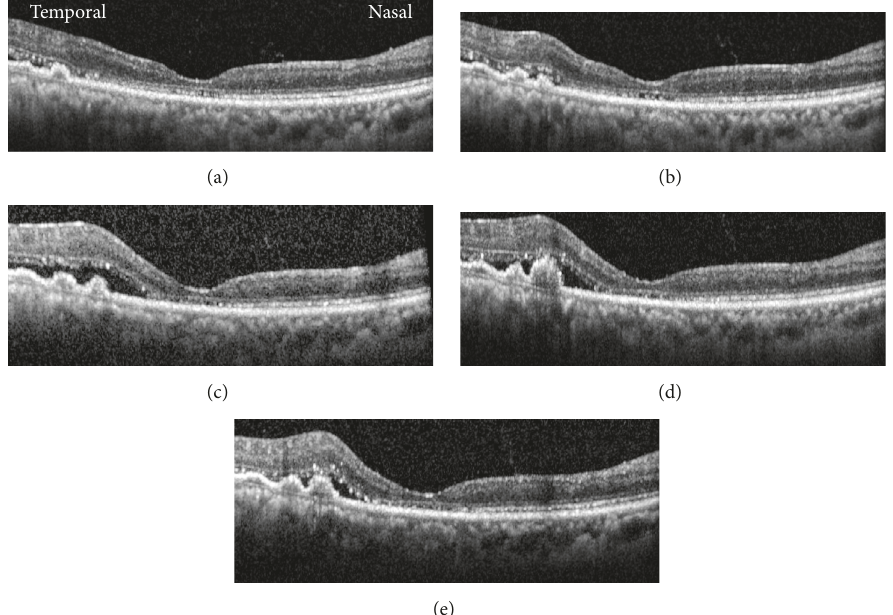
Figure 2: Spectral domain-OCT images of right macula from baseline (a) through follow-up at various intervals: +4 months (b), +7 months (c), +8 months (d), and +9 months (e). Note the waxing and waning of subretinal fluid, the variations in the appearance of the temporal pigment epithelial detachments, and the fovea remaining dry throughout